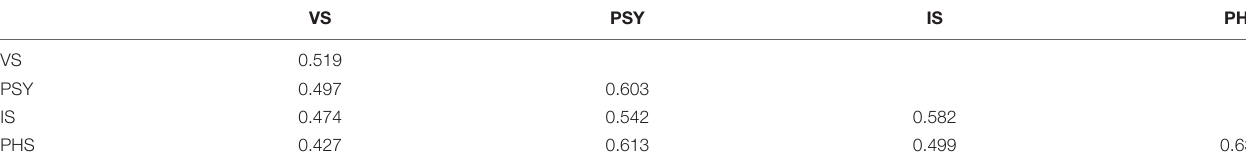
TABLE 7 | Results of psychological symptom assessment in metro drivers surveyed by SCL-90. Psychological